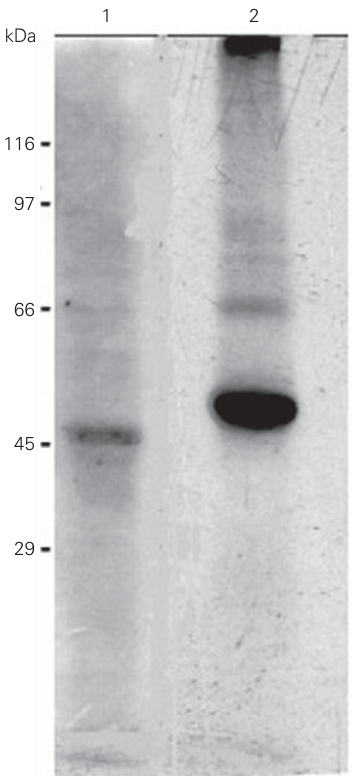
Figure 7. (cid:0) Glycoprotein nature of the (cid:1) -L-fucosidase from Trypa- nosoma cruzi . Extracts of epi- mastigotes metabolically la- beled in the presence (lane 1) or absence (lane 2) of 10